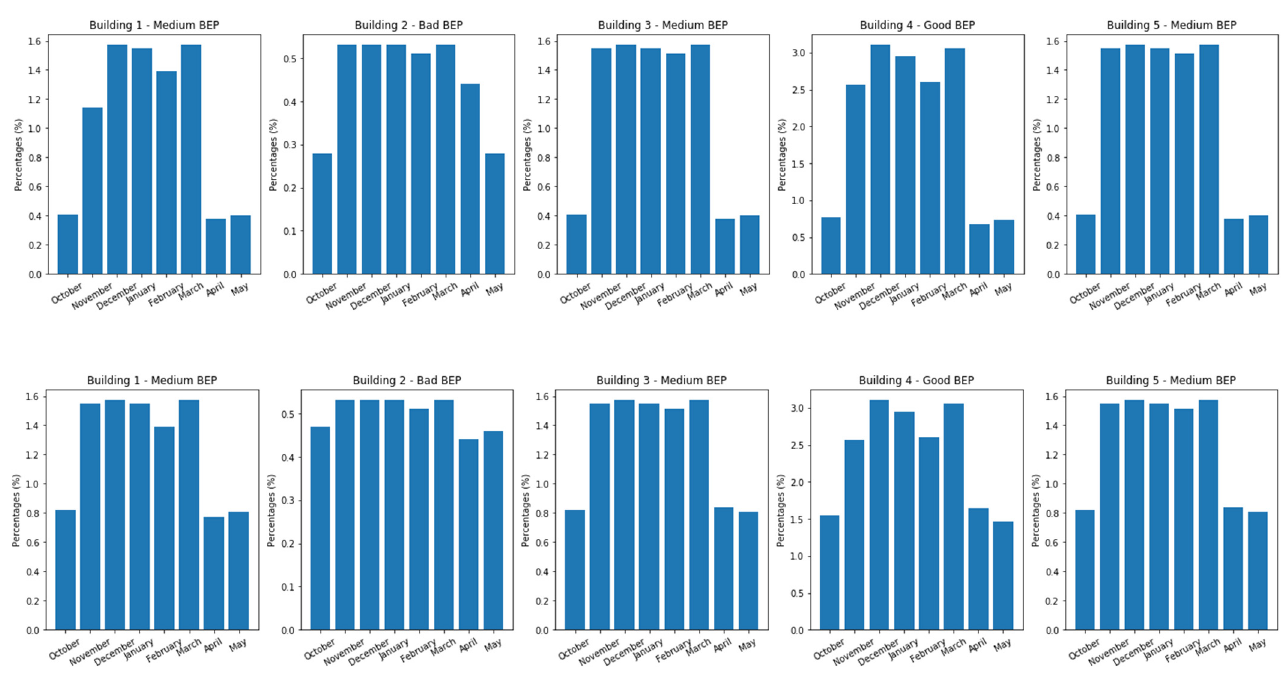
Figure 14. Energy savings obtained based on modelled data ( top , worst-case estimation; bottom , best-case estimation).